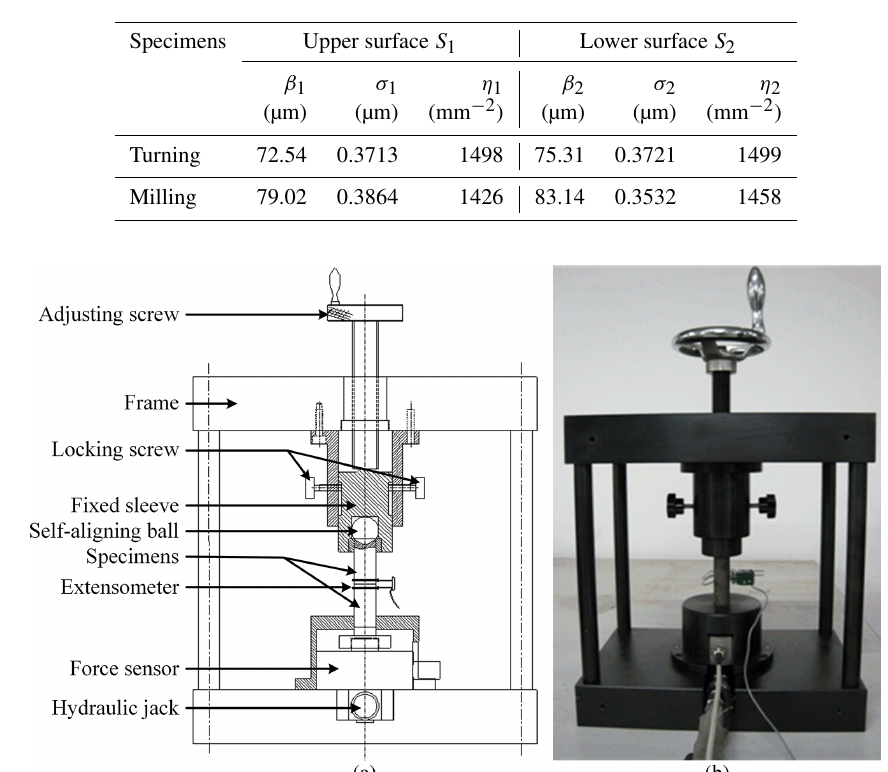
Table 1. Statistical parameters of the measured contact surfaces.